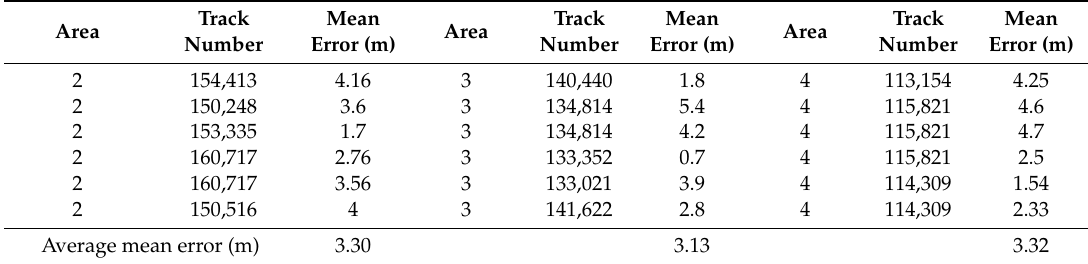
Table 3. Along-track positioning accuracy for three areas.